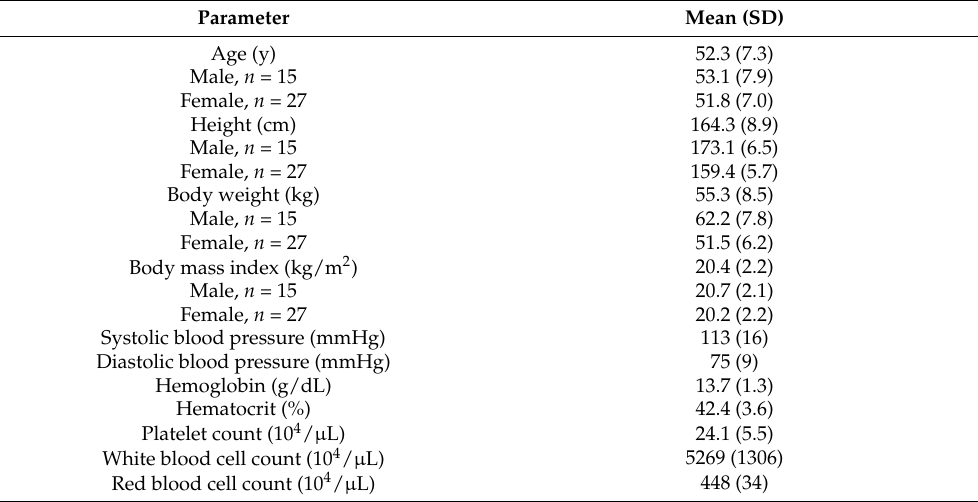
Table 1. Characteristics of the study participants ( n = 42).